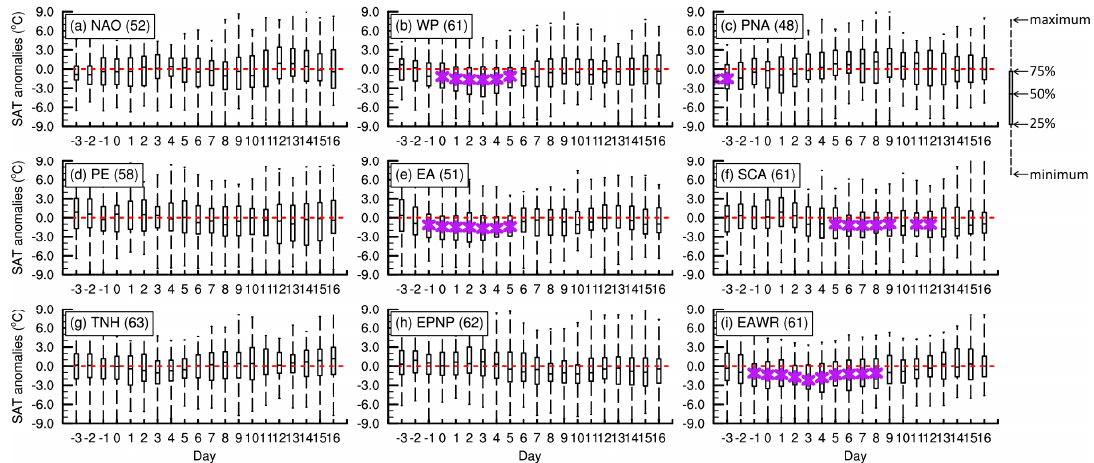
Figure 2. ( a – i ) Boxplots of daily SAT anomalies averaged over eastern China during the evolution of nine teleconnection patterns in their positive phases during the 40 winters from 1979 to 2018. Abscissas represent days relative to the peak day of the teleconnection pattern. Purple asterisks represent composite anomalies that are significant at the 0.05 level, based on two-tailed Student’s t test controlled by false discovery rates of each teleconnection pattern is indicated in top-right of the corresponding panel. Name and numbers in top left of panels indicate the name of teleconnection pattern and number of cases used for the composite analysis, respectively.